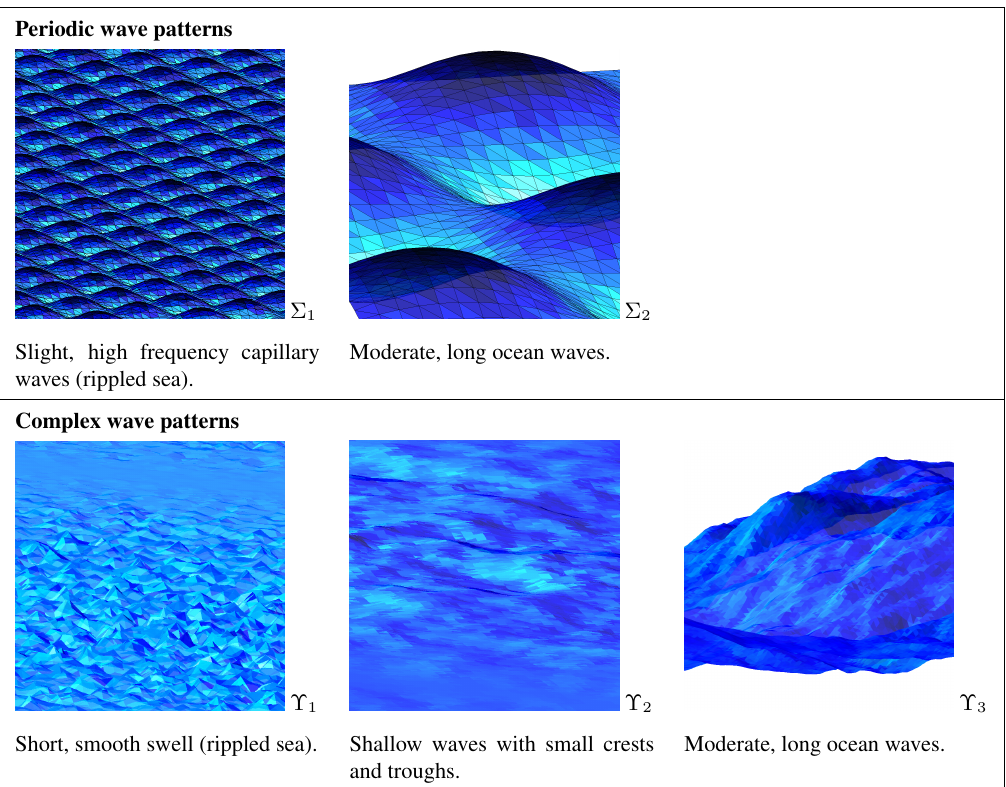
Table 1: Level of complexity in water surface modelling: The effects of water surface inclination on bottom point determination are analysed for periodic ( Σ ) as well as complex wave structures ( Υ ).